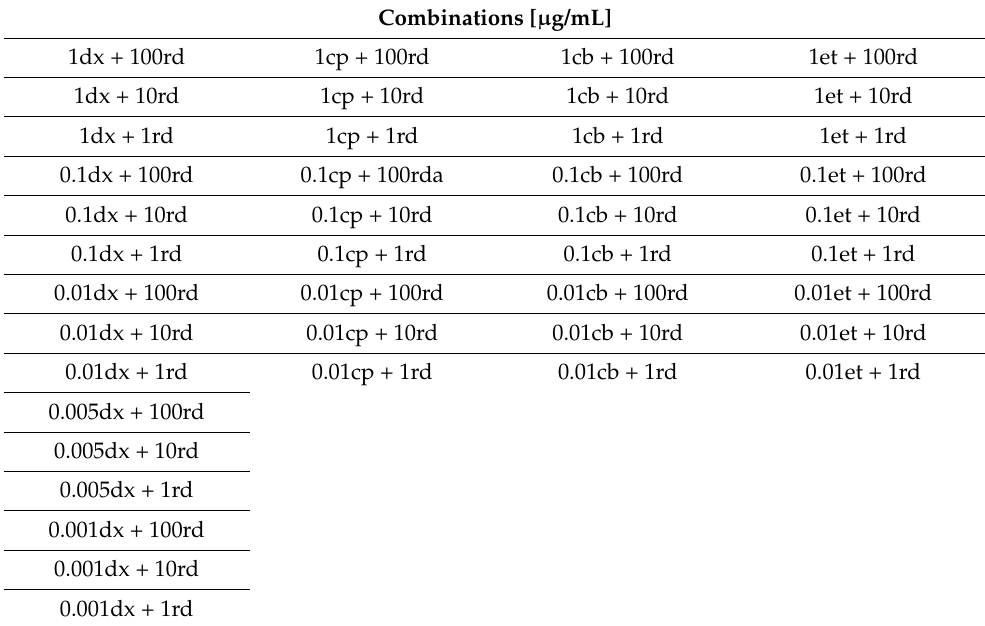
Table 1. Tested drug combinations: dx—doxorubicin, cp—cisplatin, cb—carboplatin, et—etoposide, rd—risedronate